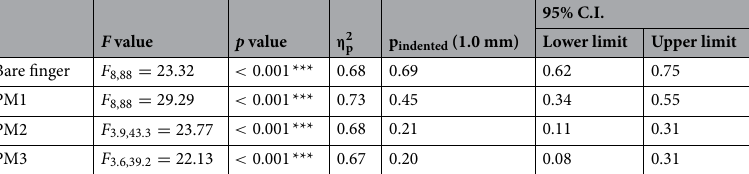
Table 1. Statistical analysis of the effect of rib intervals in each touch conditions (bare finger, PM1, 2, and 3) (see Fig. 1a). All main effects of touch conditions were significant. *** and C.I. denote p < 0.001 and confidence interval, respectively.